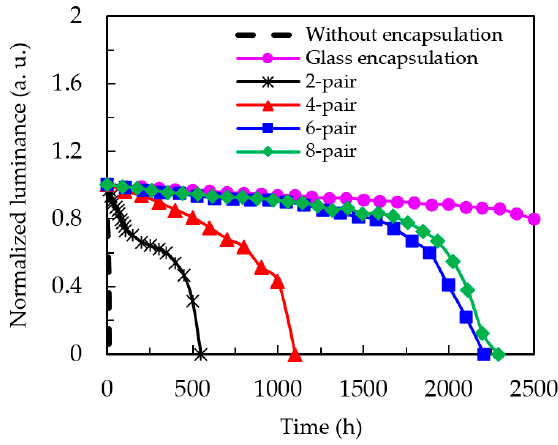
Figure 4. Normalized luminance of the OLED devices without encapsulation, with glass encapsulation, and with different numbers of pairs of SiO x /SiC x H y encapsulation as a function of operation time.